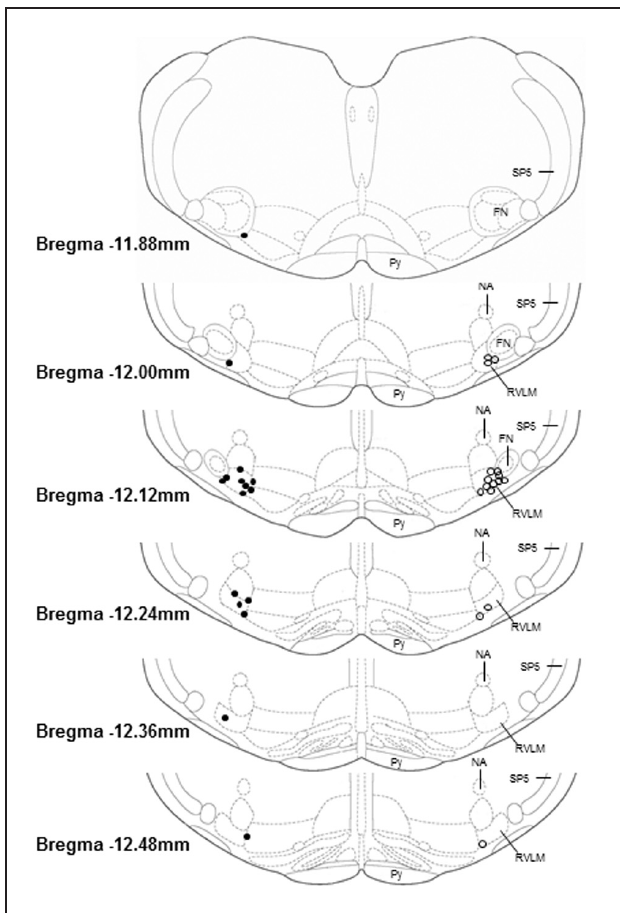
FIGURE 5 | Histological representation of microinjection sites plotted on brainstem sections that have been modified from a standard rat atlas (Paxinos and Watson, 2007). Unilateral injection sites from sedentary (filled circles, n = 16) and physically active animals (open circles, n = 16) are plotted on opposite sides for clarity. All microinjection sites were associated with pressor and sympathoexcitatory responses to glutamate; were confined within the general boundaries of the rostral ventrolateral medulla (RVLM); and were distributed similarly between groups. FN, facial nucleus; NA, nucleus ambiguus; Py, pyramidal tract; SP5, spinal trigeminal